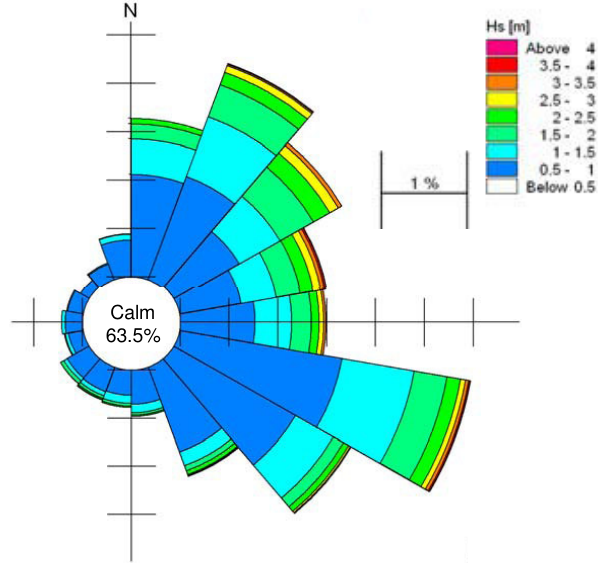
Fig. 6. Wave heights directional distribution offshore the study site.